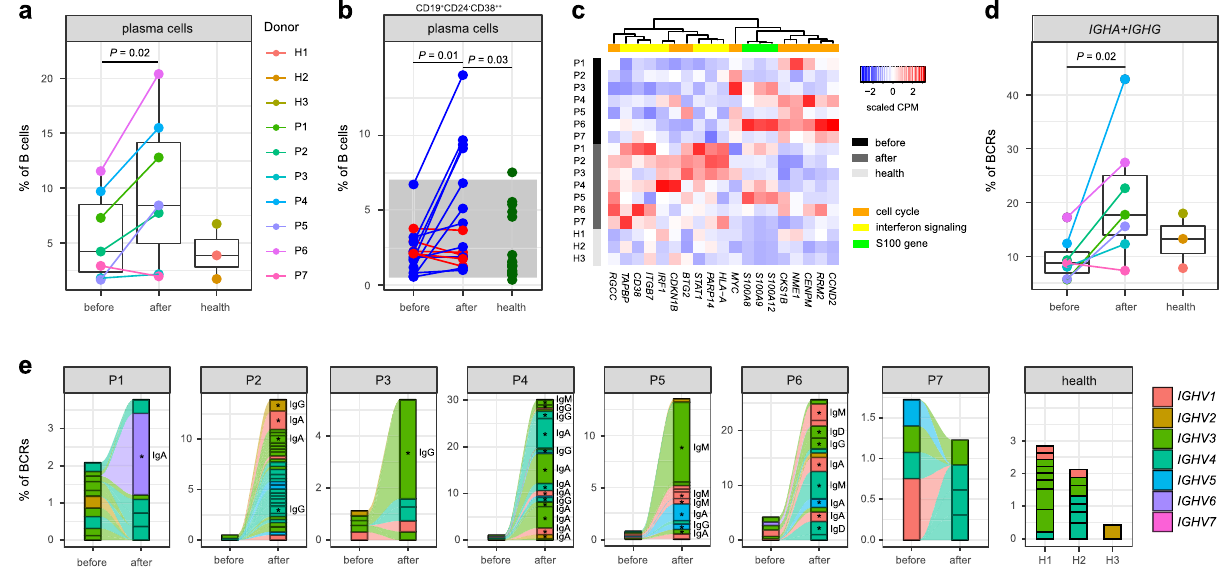
Fig. 4 Characterization of B cells and BCRs. a Percentage of plasma cells across conditions recovered by scRNA-seq (KD patients n = 7, healthy controls n = 3). The samples are colored according to donors. P -values are calculated by using the two-sided t -test. b Percentage of plasma cells (CD19 + CD24 − CD38 ++ ) by fl ow cytometric validation on additional KD patients ( n = 16) and healthy controls ( n = 20). Patients with a decreased percentage after therapy are colored in red, and patients with an increased percentage after therapy are in blue. Healthy controls are colored in green. The gray area represents the reference range of the panel. P -values between conditions are calculated by using the two-sided t -test. c Heat map of DEGs with functional enrichment in B cells. Gene expression on the sample level is measured by the counts per million mapped reads (CPM), which is then scaled across samples. d Percentage of IGHA and IGHG in BCRs across conditions recovered by scBCR-seq (KD patients n = 7, healthy controls n = 3). The samples are in the same colors as ( a ). P -values are calculated by using the two-sided t -test. In ( a ) and ( d ), data are represented as boxplots where the middle line is the median, the lower and upper hinges correspond to the fi rst and third quartiles, and the whiskers extend from the hinge to the farthest data point within a maximum of 1.5× interquartile range. e BCR clonotype tracking in each patient. The clonotype composition is represented by stacked bar plots, which are colored according to IGHV families. Only clonotypes with clonal size ≥ 3 are plotted, and proportion of BCRs in these clonotypes are compared before and after therapy by using the two-sided Fisher ’ s exact test. Individual clonotypes with FDR < 0.01 are marked with stars. Source data are provided in the Source Data fi